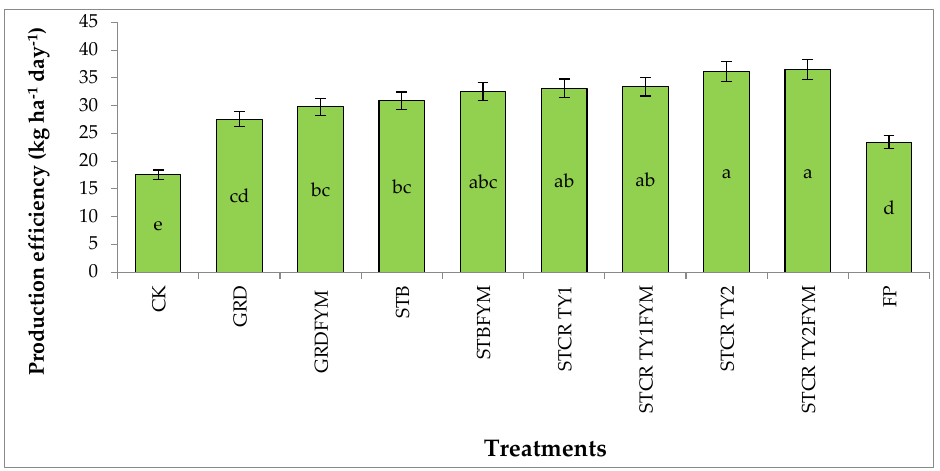
Figure 3. DSR production efficiency under different treatment combinations. Bars with the same letter are not different at a 5% probability level; error bars indicate the standard deviation of the respective means.